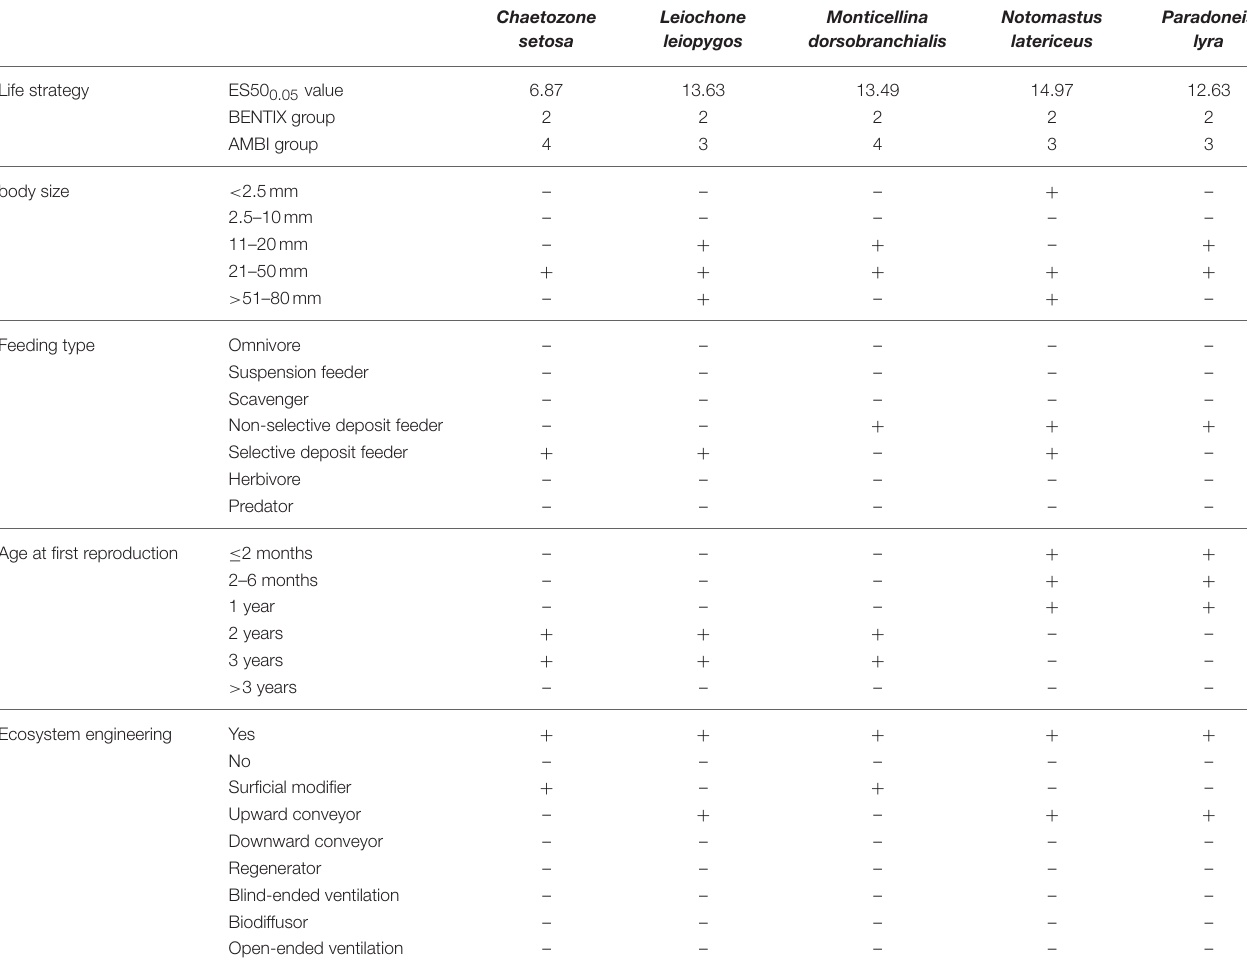
TABLE 5 | Functional traits of the 5 macrofaunal species responsible for the greater dissimilarities between groups of samplers (Ambient, Control, Low eutrophication, High eutrophication) as indicated by the SIMPER